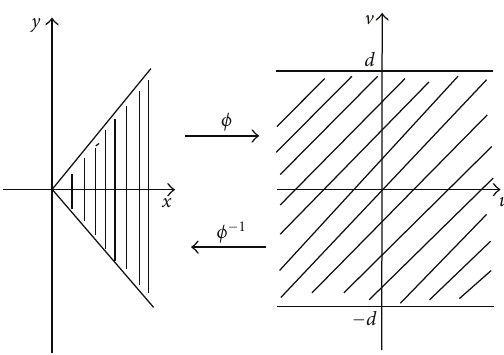
F 1: �ye-shaped domain and the in�nite